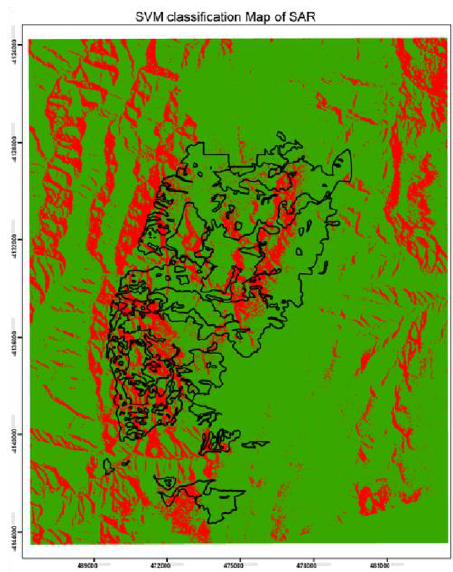
Figure 6. Classified map of ALOS-2 imagery of study area. Red colour representing burnt areas and green representing unburnt areas.